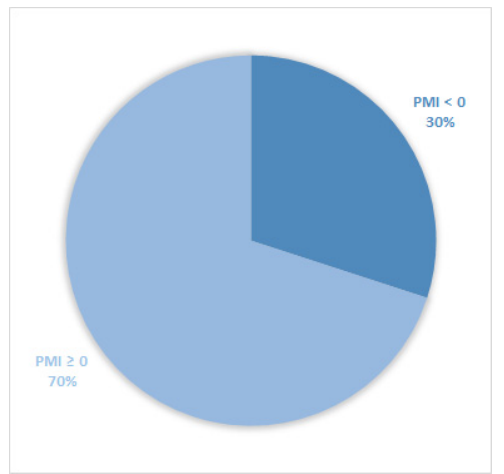
Figure 5. Pie chart displaying the percentage of patients with PMI < 0 and PMI ≥ 0. Only patients undergoing palliative radiotherapy and with pain or receiving analgesics were included (737).